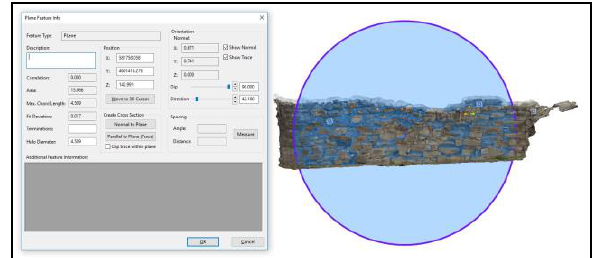
Figure 9. Section Plane Angle Calculation in 3DM Analyst